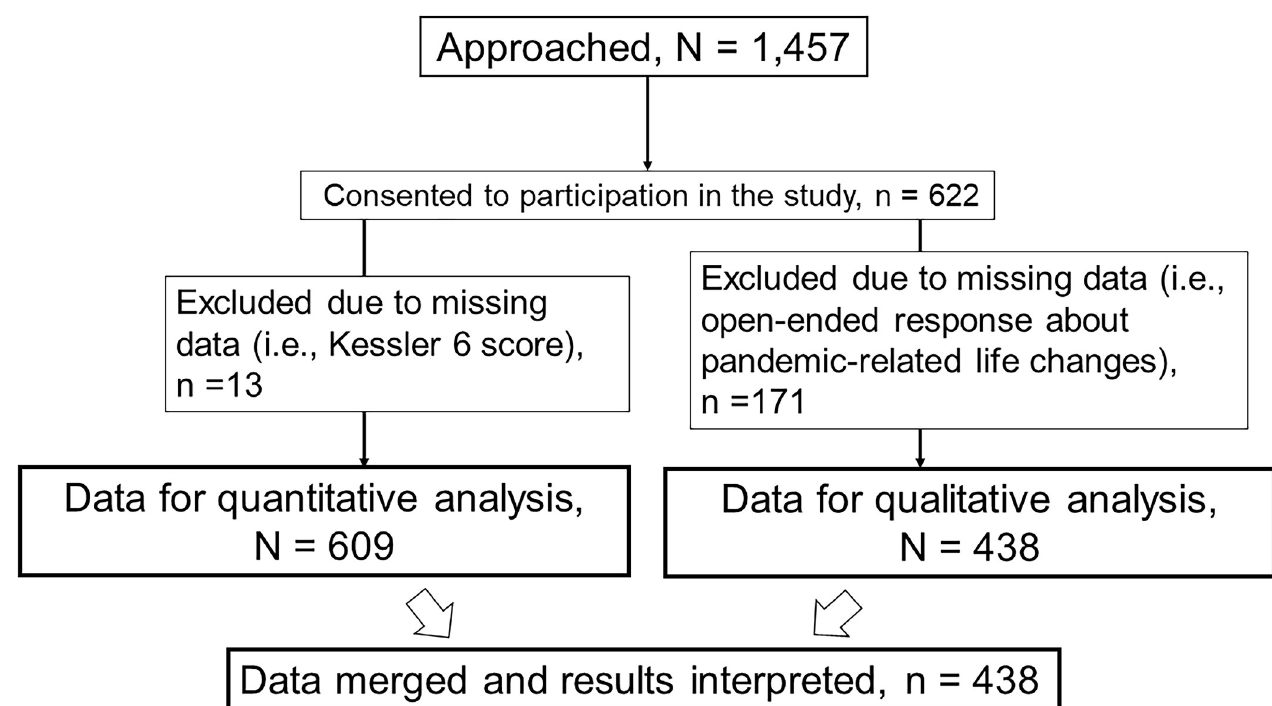
Fig 2. Code clouds of pandemic-related changes. Participants with psychological distress (a) and those without (B).